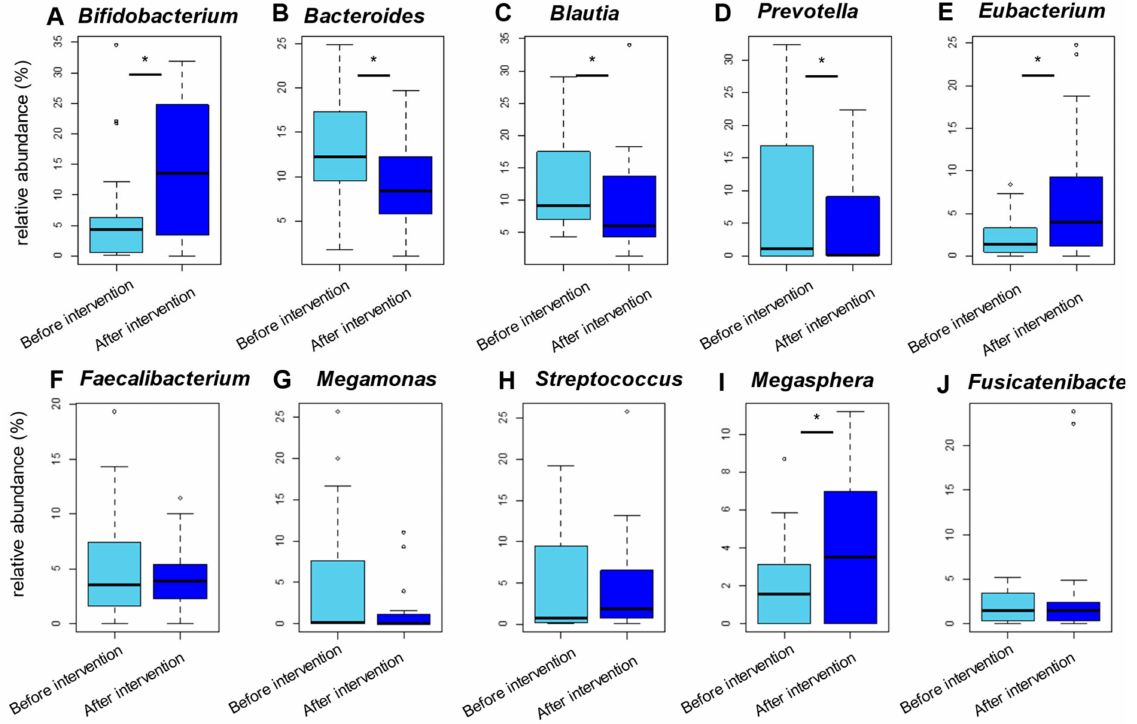
Figure 2. Alterations in the microbiome at the genus-level associated with the intervention of acarbose. Comparison of the abundance at the genus-level before and after the intervention of acarbose based on 16S data. ( A ), Bifidobacterium; ( B ), Bacteroides; ( C ), Blautia; ( D ), Prevotella; ( E ), Eubacterium; ( F ), Faecalibacterium; ( G ), Megamonas; ( H ), Streptococcus; ( I ), Megasphera; ( J ), Fusicatenibacte.Top ten abundant genera are represented. Each box plot shows median, interquartile range, minimum, and maximum values; * p < 0.05 based on the paired t -test. ( A ), represents genus Bifidobacterium ; ( B ), represents genus Bacteroides ; ( C ), represents genus Blautia ; ( D ), represents genus Prevotella ; ( E ), represents genus Eubacterium ; ( F ), represents genus Faecallbacterium ; ( G ), represents genus Megamonas ; ( H ), represents genus Streptococcus ; ( I ), represents genus Megasphera ; and ( J ), represents genus Fusicatenibacte